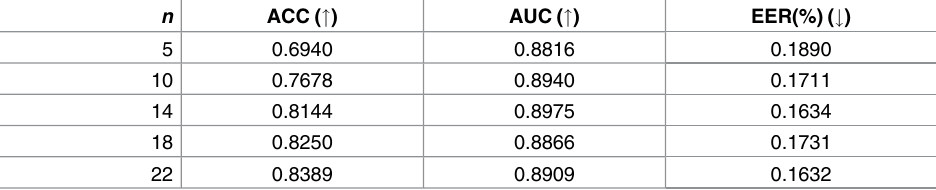
Table 2. Performance of the systemtrained with varying number n of samples of genuine signatures; " and # denote measuresof quality (the higher the better) and of error (the smaller the better), respectively.